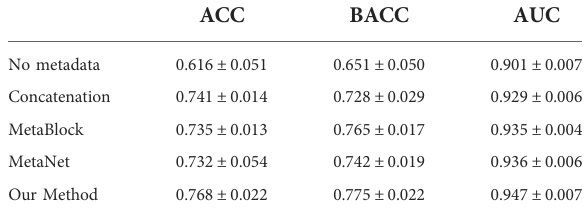
TABLE 2 Performance comparison of different methods.